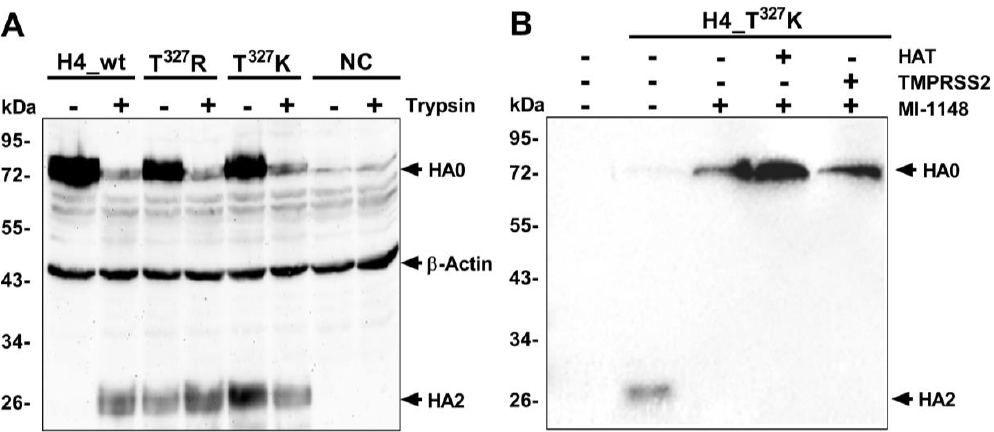
Figure 4. Cleavability of the HA after transfection of HEK293T cells. Cleavability of the HA of